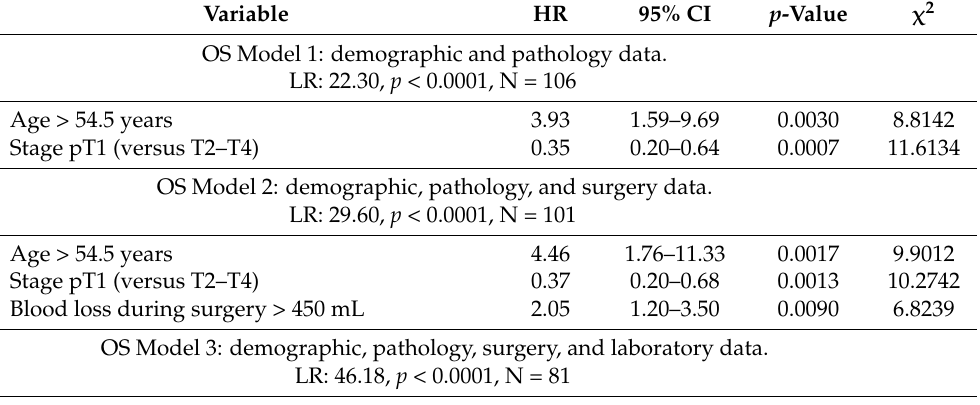
Table 4. Independent predictors of OS and RFS based on multivariate Cox